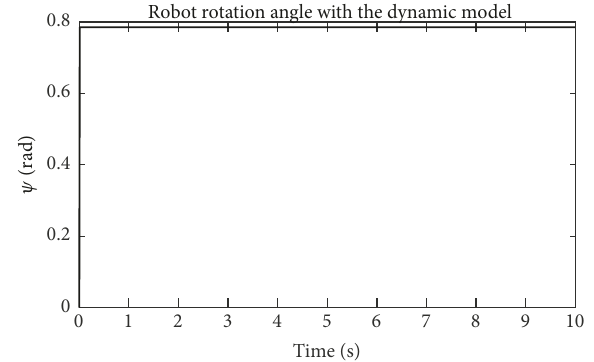
Figure 14: Rotation angle in the case of dynamic predictive control.